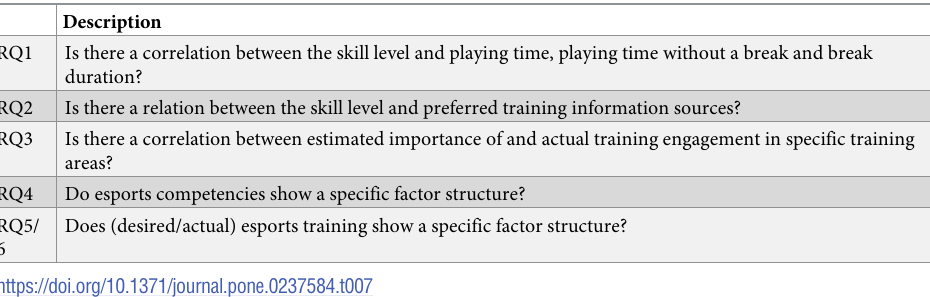
Table 7. Research questions (RQ).